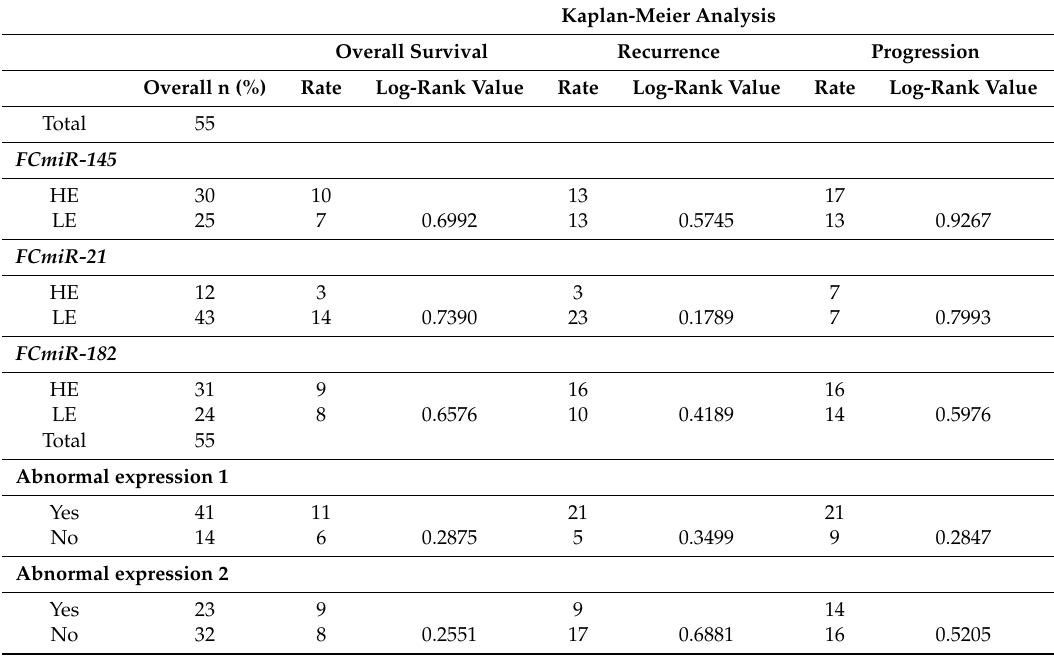
LE—low expression; HE—high